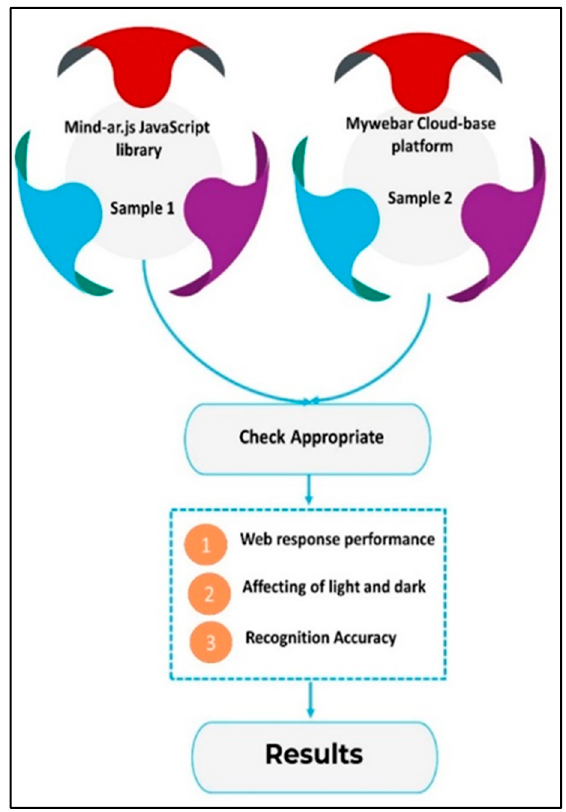
Figure 1. Flow of Web AR samples test .